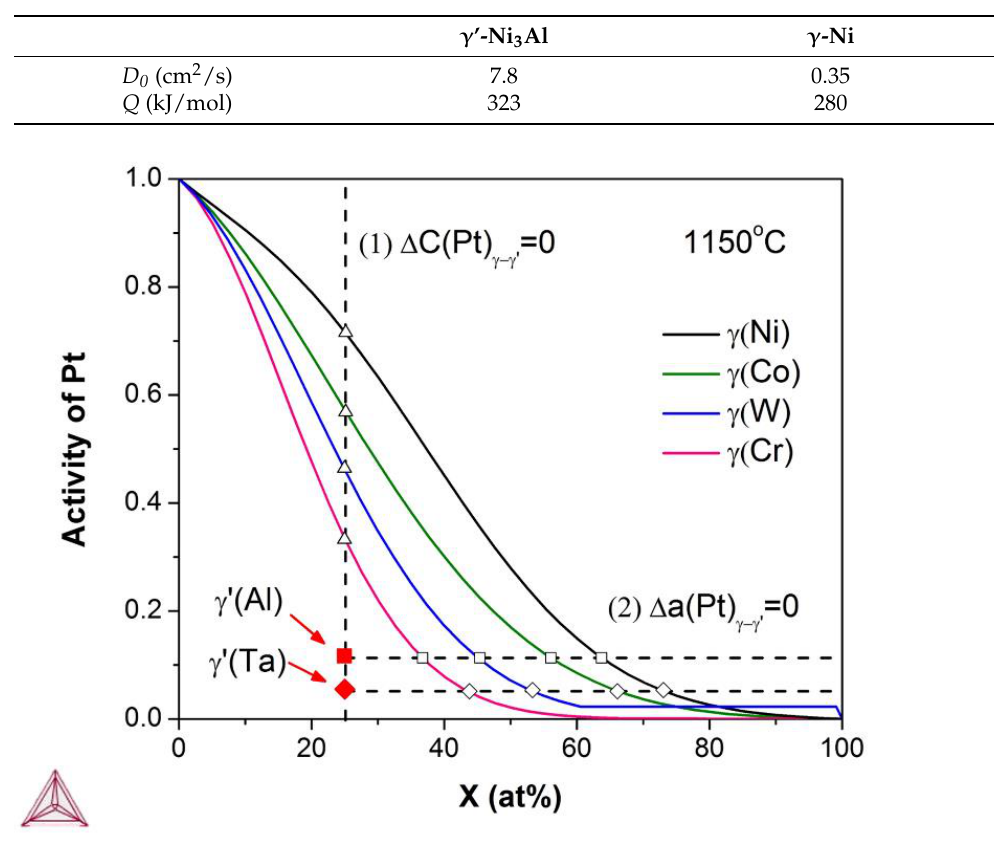
Figure 9. Dependency of the activity of Pt on the concentration of additional alloying elements at 1150 °C in a binary system. 1150 ◦ C in a binary